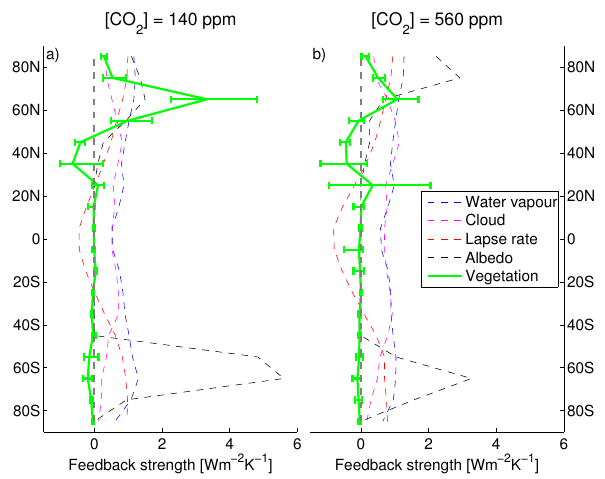
Fig. 12. Zonal mean feedback strength for experiments with 140ppm (left) and 560ppm (right). The ensemble median is plotted for all feedbacks and the 5–95 percentile range from the ensemble is additionally plotted for the vegetation